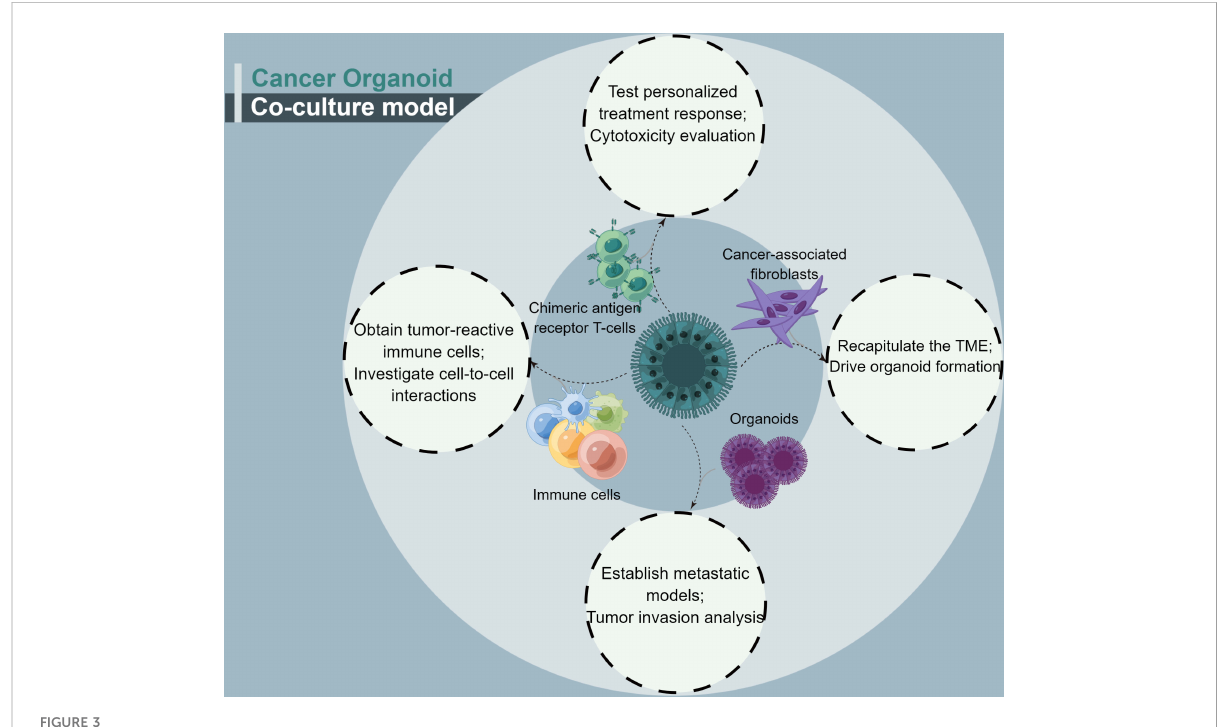
FIGURE 3 A summary of the four conditions for cancer organoids